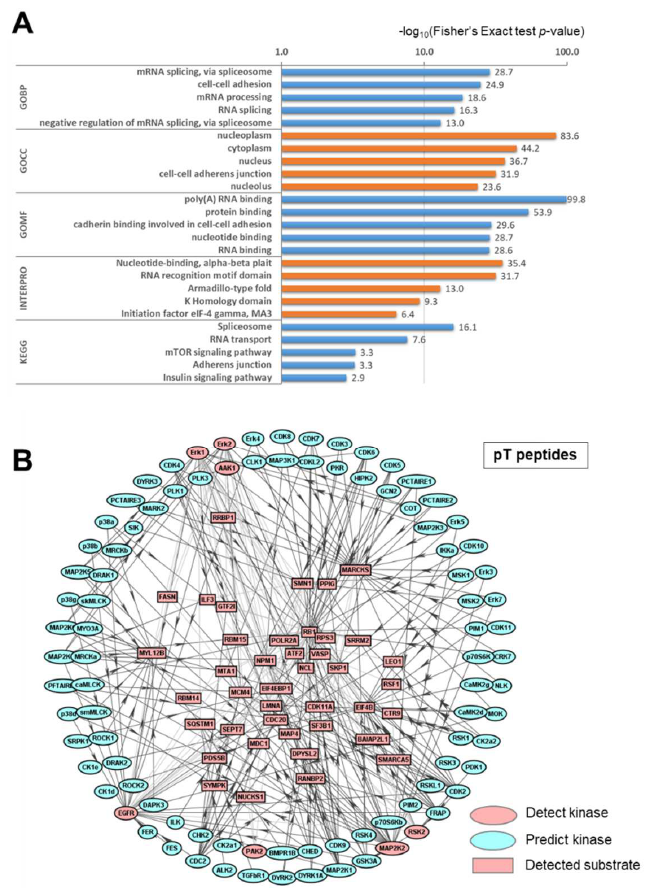
Figure 2. Characterization of time-dependently upregulated phosphorylation by α-amanitin (α-AMA) treatment of Huh-7 cells. ( A ) DAVID-generated Gene Ontology (GO) enrichment and Kyoto Encyclopedia of Genes and Genomes (KEGG) pathway analysis of Cluster 8. ( B ) Kinase–substrate interaction analysis of phospho-threonine proteins using iGPS 1.0. Circle (Kinase), Square (Substrate), Pink (Detected), and Blue (Predicted).